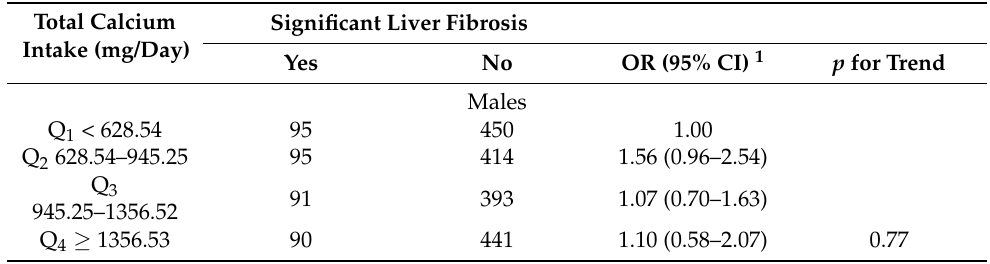
Table 4. Associations between intake of total calcium and odds of significant fibrosis by